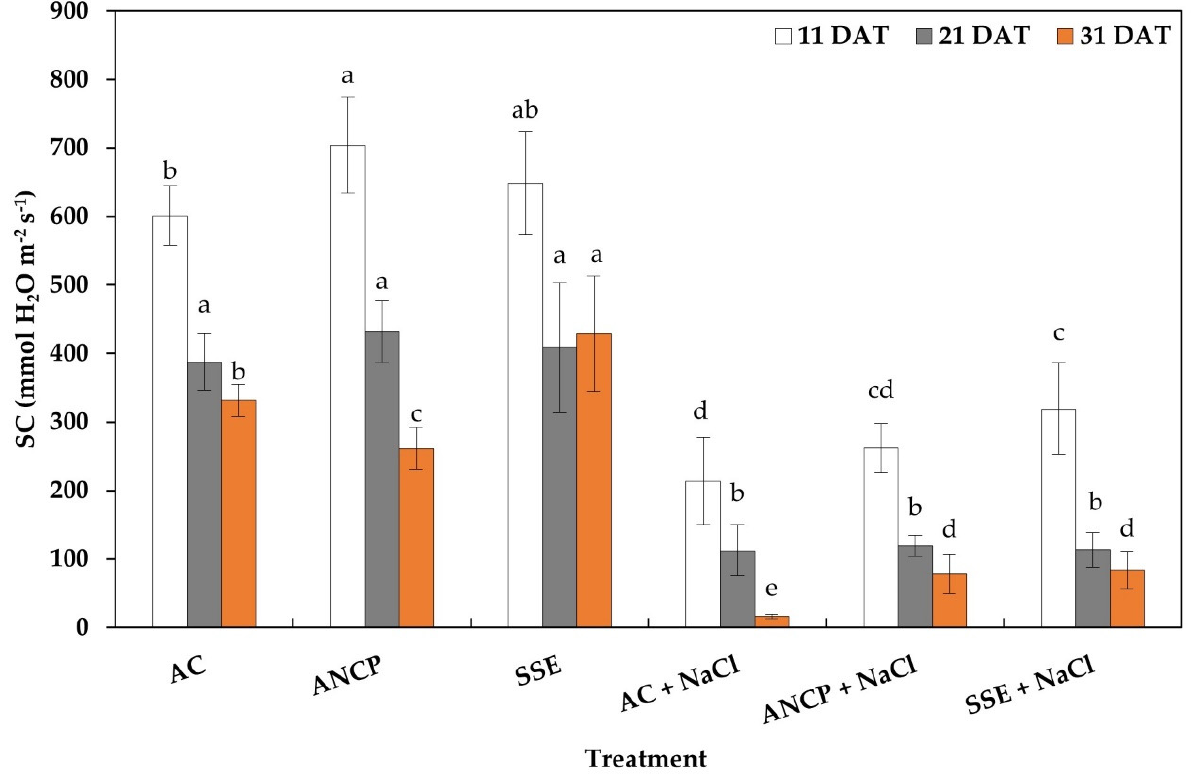
Figure 2. Stomatal conductance in the leaves of tomato seedlings. Different letters within each column indicate significant differences between treatments (LSD, p ≤ 0.05). DAT: Days after transplant; SC: Stomatal conductance; AC: Absolute control; ANCP: A. nodosum commercial product; SSE: Sargassum spp. seaweed extracts; NaCl: 100 mM sodium chloride; n = 5; ± bar intervals represent the SD.